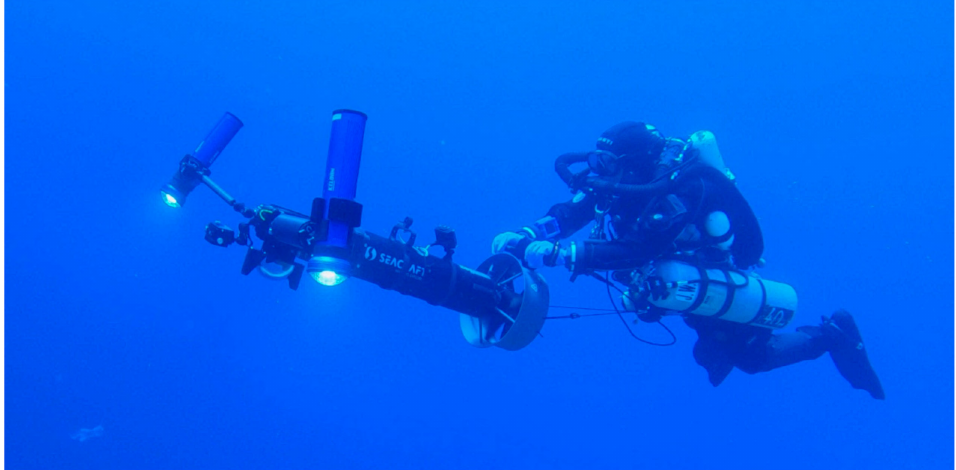
Figure 4. DPV camera setup. The use of video camera, attached to the top of the main camera, is an added tool that can aid in the process of image alignment. It also ensures that a back-up is available should the main camera malfunction. © Joseph